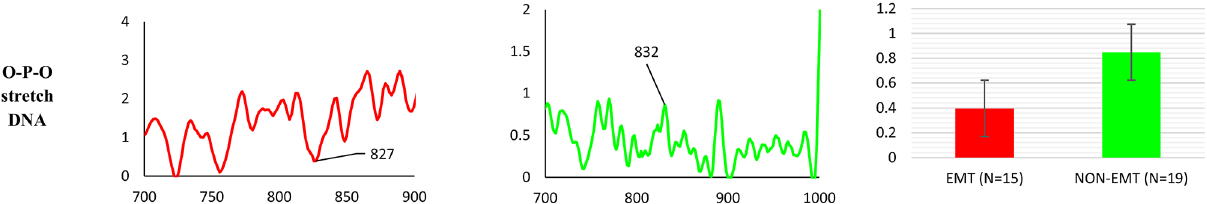
Figure 9. The nucleic acid vibrational bands of O–P–O stretch observed for waxed samples (Group 2) in non-EMT breast cancer tissue. Each column represents average of spectra for each type of tissue. The value of N represents the number of Raman spectra acquired for each sample, shown within the brackets. The error bar represents standard deviation. The x-axis represents the wavenumber while the y-axis represents the intensity. No statistically significant differences between the groups are reported by the